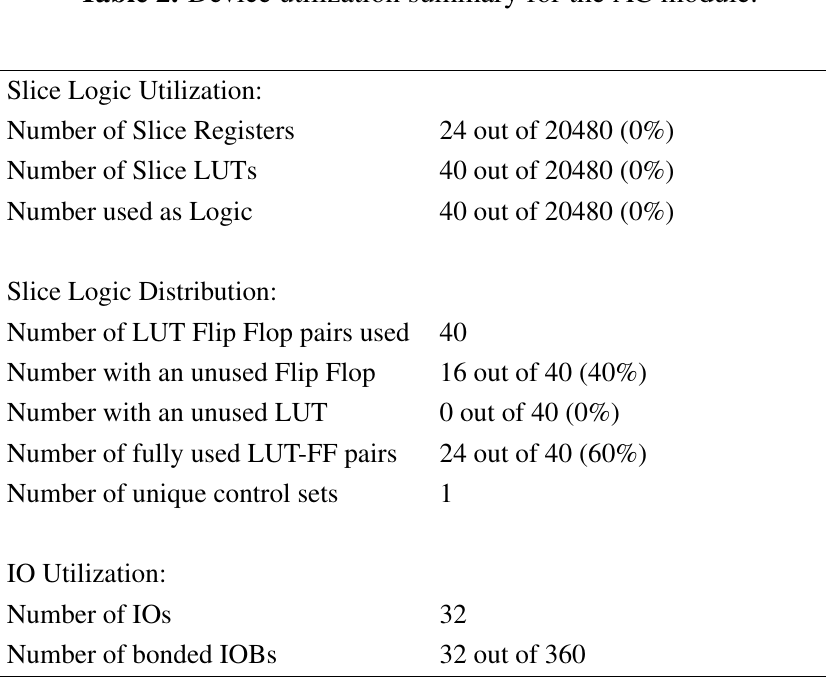
Table 2. Device utilization summary for the AC